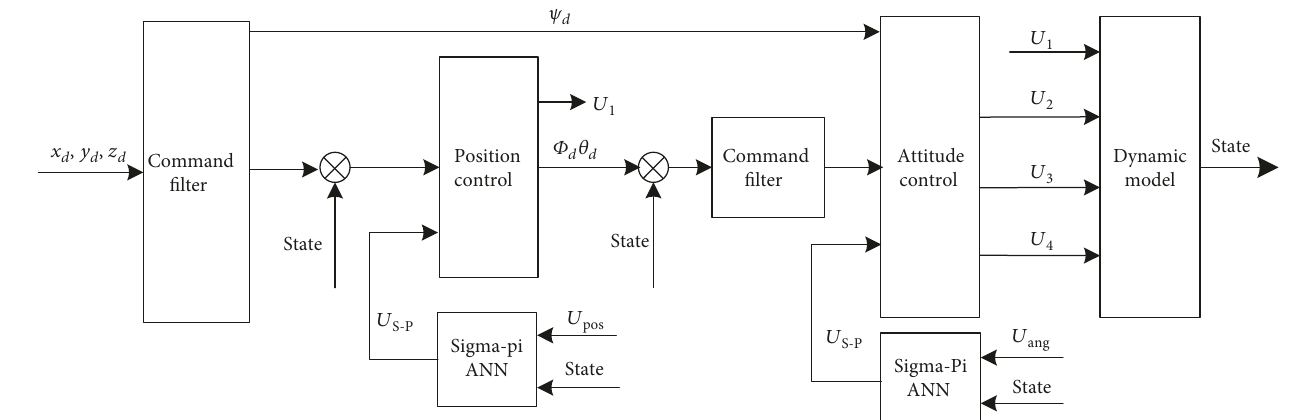
Figure 3: The control loop with sigma-pi neural network compensation.